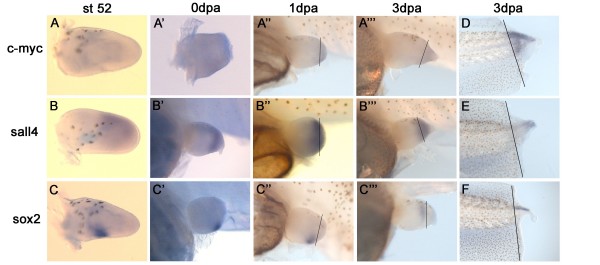
In situ hybridization of c-myc, sall4 and sox2 in developing and regenerating limbs and tails. A-A"') Expression of c-myc in developing st52 limbs (A) and amputated limbs at 0 dpa, 1 dpa and 3 dpa (A'-A"'). c-myc expression is diffuse and very weak in the developing limb bud and the blastema. B-B"') Expression of sall4 in developing st52 (B) and regenerating limbs at 0 dpa, 1 dpa, 3 dpa (B'-B"'). sall4 is expressed diffusely in the distal mesenchyme of the developing limb bud and after amputation in the whole of the blastema. C-C"') Expression of sox2 in developing (C) and regenerating (C'-C"') limbs. sox2 is expressed proximal to the blastema in the posterior mesenchyme. D) c-myc mRNA is expressed in the entire regeneration bud of a 3 dpa tail and is much stronger than in limbs. E) sall4 mRNA expression in 3 dpa tail is mainly seen in the distal tip of the regenerating tail. F) sox2 mRNA expression in 3 dpa tail is confined to the neural tube. (dpa = days post amputation). Thin black line indicates amputation plane